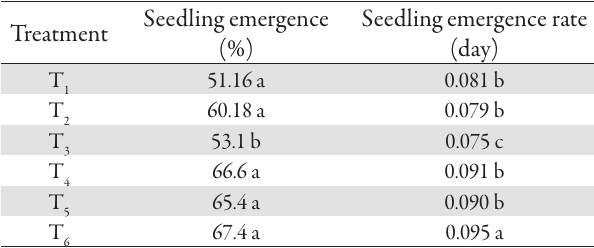
Tab. 3. Comparison of means for seed priming effects on cowpea for field emergence and establishment